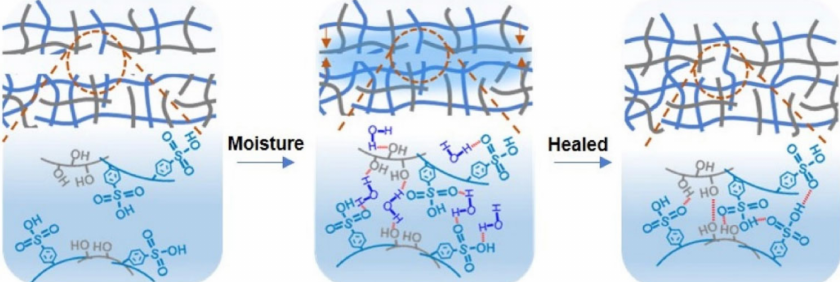
Figure 14. Scheme of the moisture-induced healing process among the PSS-PVA chains: an initial crack (left), its fusion under the influence of moisture (middle) and restoration to its original state (right). Reproduced from [140] with permission from